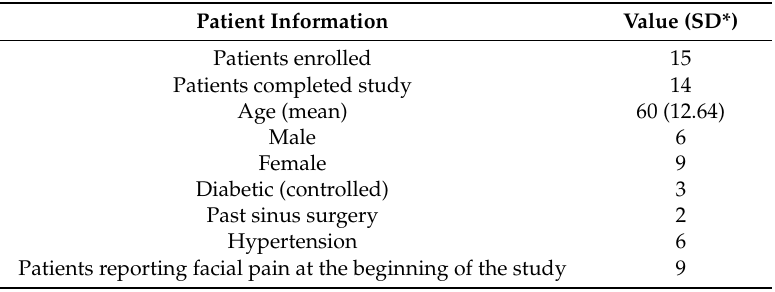
Table 1. Patient baseline demographic data. All patients maintained stable medication